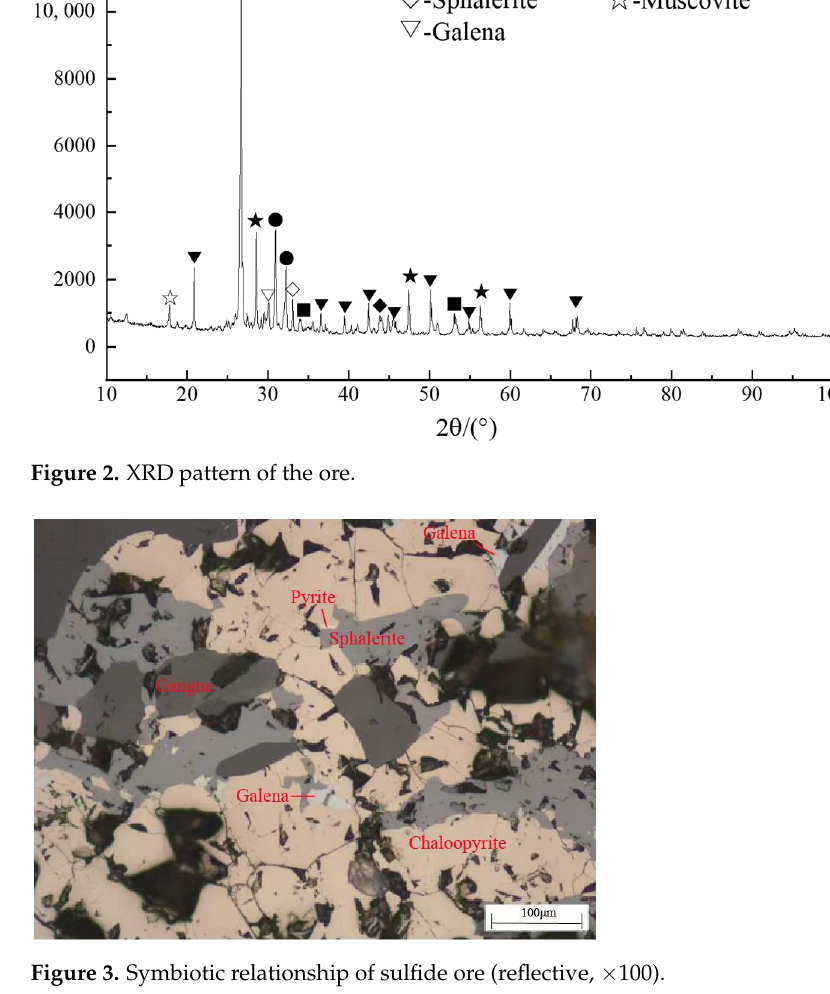
Figure 3. Symbiotic relationship of sulfide ore (reflective, ×100).